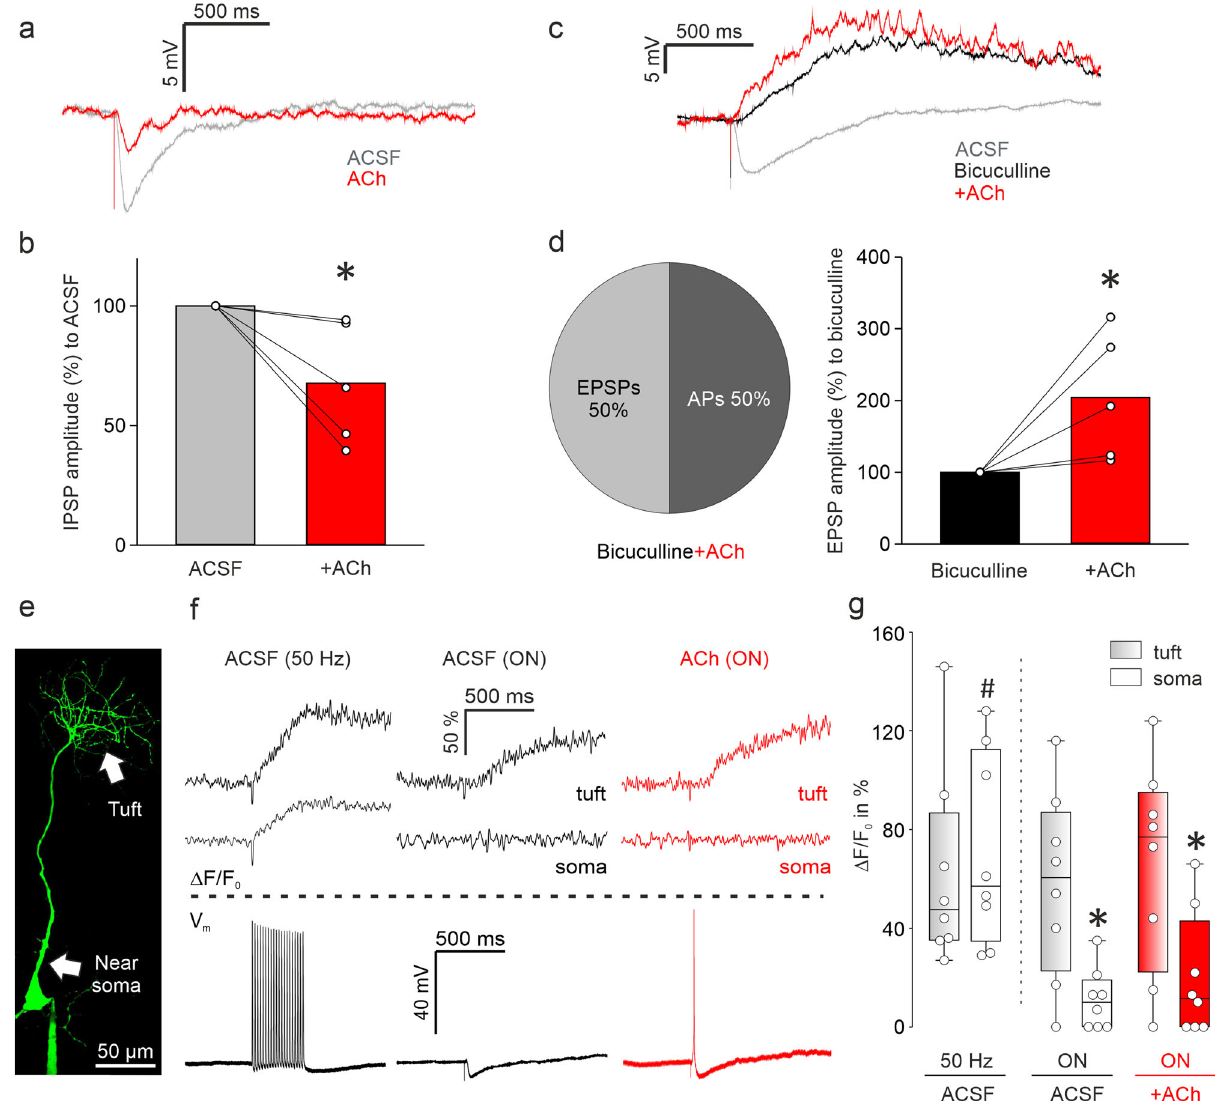
Fig. 3 ACh modulates both ON-evoked inhibition and excitation via muscarinic receptors but does not increase intracellular Ca 2 + in fl ux. Whole-cell patch-clamp recordings in 300 µ m in vitro slices of responses from VPCs to electrical ON stimulation (50 µ A, 100 µ s, 30 s intervals). a Representative averaged traces of responses following ON stimulation in the ACSF condition (gray) and during bath application of ACh (acetylcholine, red) showing reduced IPSPs. b Cumulative analysis of normalized evoked IPSP amplitudes to the ACSF condition during bath application of ACh ( n = 5 cells). c Representative averaged traces of responses following ON stimulation in the ACSF condition (gray) and during bath application of bicuculline (50 µ M, black) and additional application of ACh (100 µ M, red). d Pie-chart represents the proportion of cells showing either APs or EPSPs in the ACh condition ( n = 6 cells). Bar-charts represent cumulative analysis of normalized evoked EPSP amplitudes to the bicuculline condition during additional application of ACh ( n = 5 cells). Data are presented as means including distribution of single data points. Lines between data points represent related measurements. Related- Samples Wilcoxon Signed Rank Test, * p < 0.05 vs. ACSF/Bicuculline. e Representative picture of a VPC fi lled with OGB-1. Arrows indicate the tuft and the apical dendrite near the soma. Scale bar, 50 µ m. f Representative averaged traces of Ca 2 + in fl ux in the tuft and the soma above the dotted line. Representative averaged traces of responses following ON stimulation below the dotted line (ACSF with 50 Hz somatic stimulation or ON stimulation, black; ACh with ON stimulation, red). g Δ F/F 0 in % from baseline following different stimulation and pharmacology. Data are presented as box-plots including fi rst, median, and third quartiles with whiskers representing the range of data points and distribution of single data points. (2) × (2) mixed model ANOVA (location [within subject] × treatment [within-subject]) with treatment being either 50 Hz vs. ON or ACSF vs. ACh, * p < 0.05 vs. tuft within the condition. n = 8 cells. # p < 0.05 50 Hz in the ACSF (soma) vs. ON in the ACSF (soma). n = 8/8